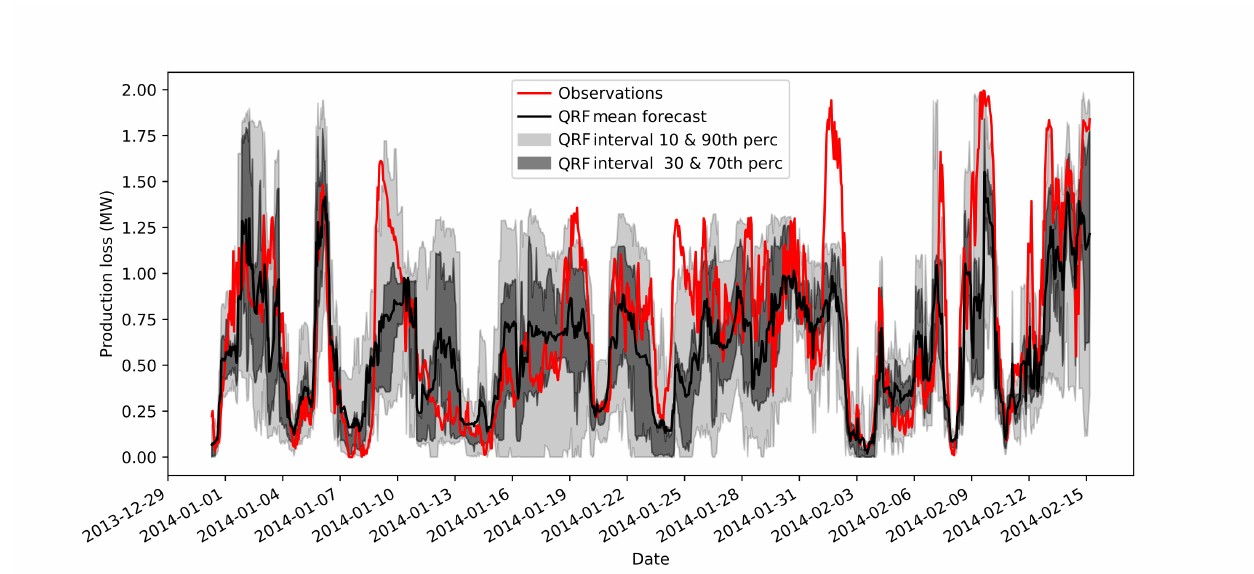
Figure 9. Probabilistic forecasts with the QRF (site A). All data and station name was used in the training. Light shaded area show 10–90th percentile range and dark shaded area 30–70th percentile of the forecast.